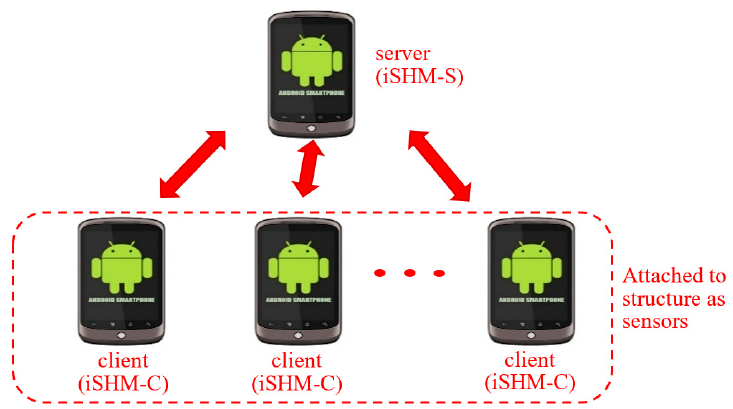
Figure 1. Network architecture of smartphone-based structural vibration monitoring system.